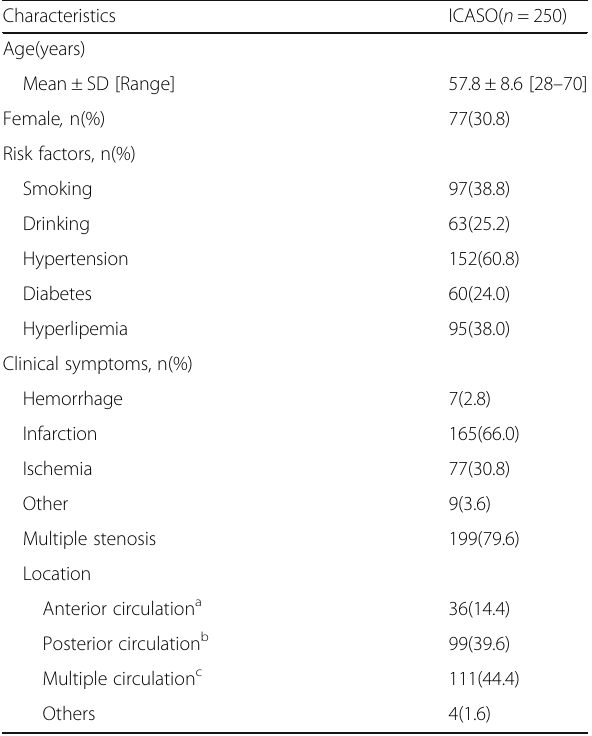
Table 1 Characteristics of the case participants and controls